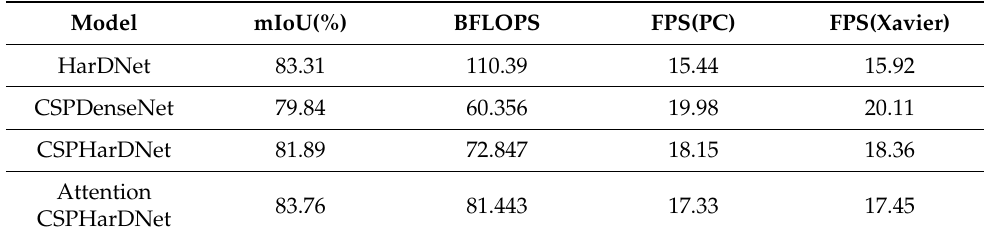
Table 4. NIA dataset results.